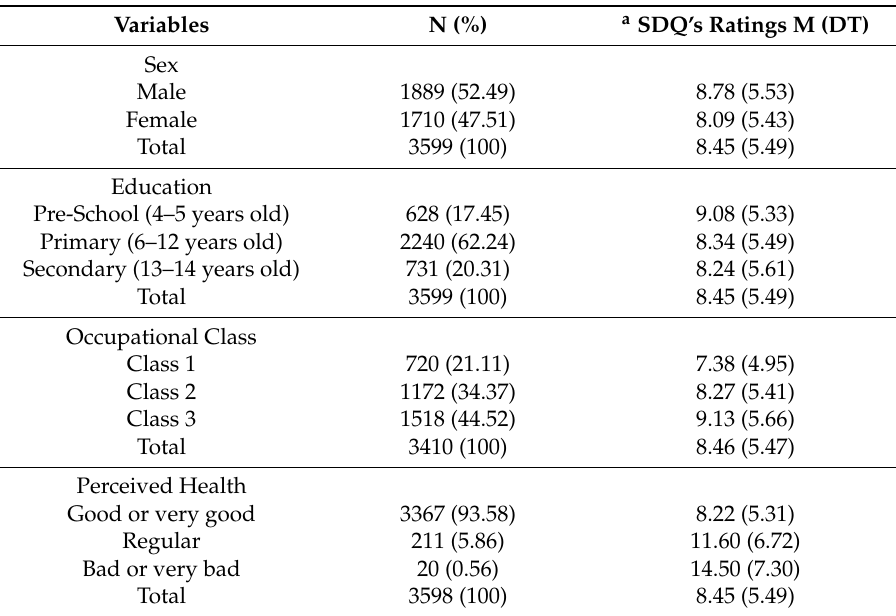
Table 1. Descriptive statistics according to the studied variables.